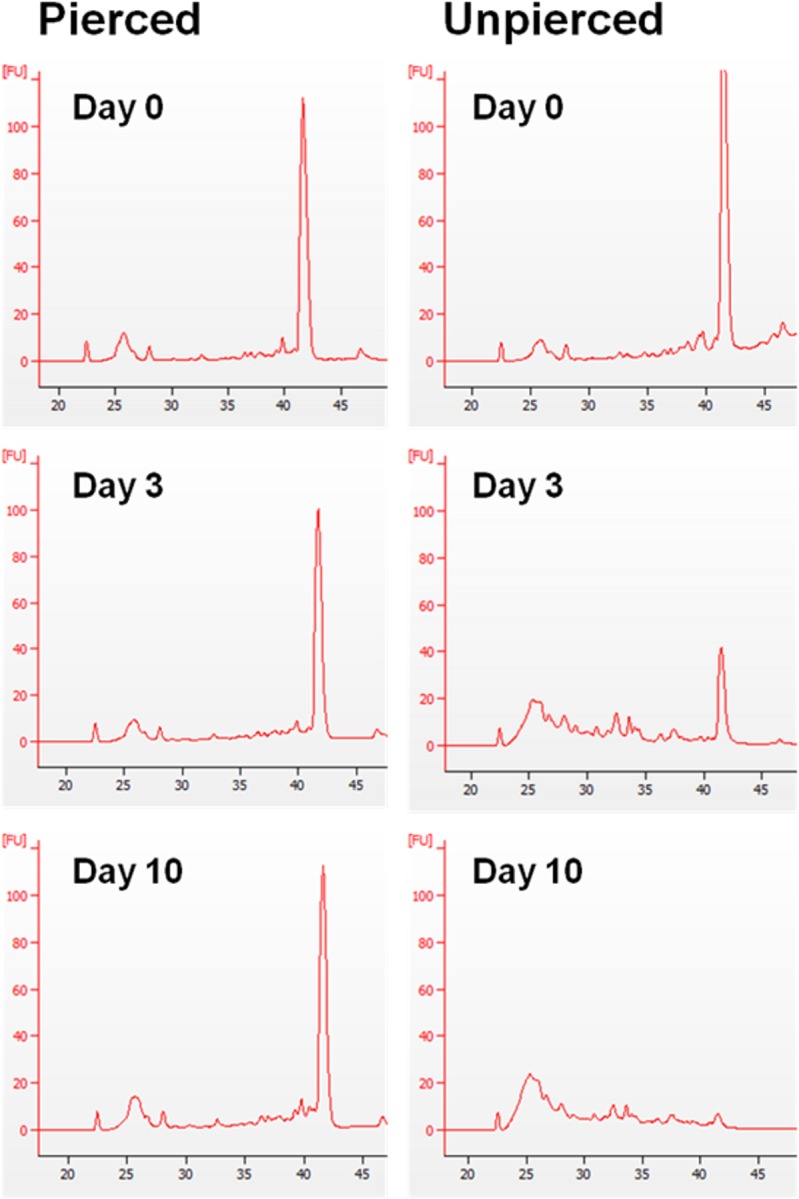
Electropherogram assessment of RNA integrity from pierced and unpierced Varroa mites collected into RNAlater after different storage conditions.Total RNA was extracted from either intact or pierced mites stored in RNAlater for 0, 3 and 10 days at room temperature. 50ng aliquots of RNA were run on the Agilent Bioanalyzer 2100 microfluidics gel analysis platform to generate electropherograms. Single 28S ribosomal peaks are seen in intact samples. Smaller peaks at 22, 26 and 28s are Agilent normalization markers and gel size ladders.